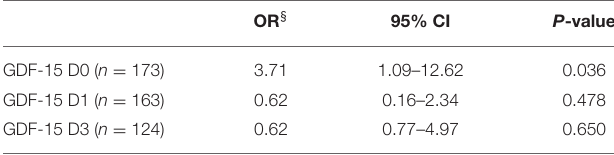
TABLE 3 | Multivariable logistic regression analysis of the association between 3-month mortality and GDF-15 levels in the third tertile of the distribution at